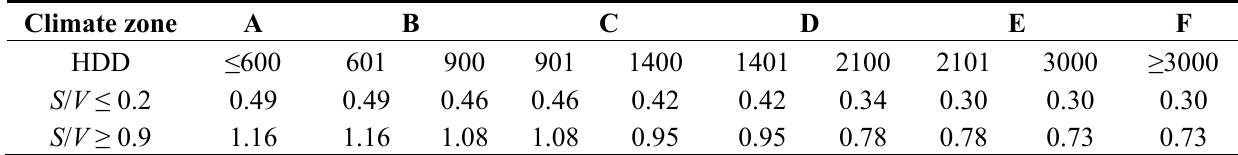
Table 1. Threshold values of the Ht coefficient. Source: